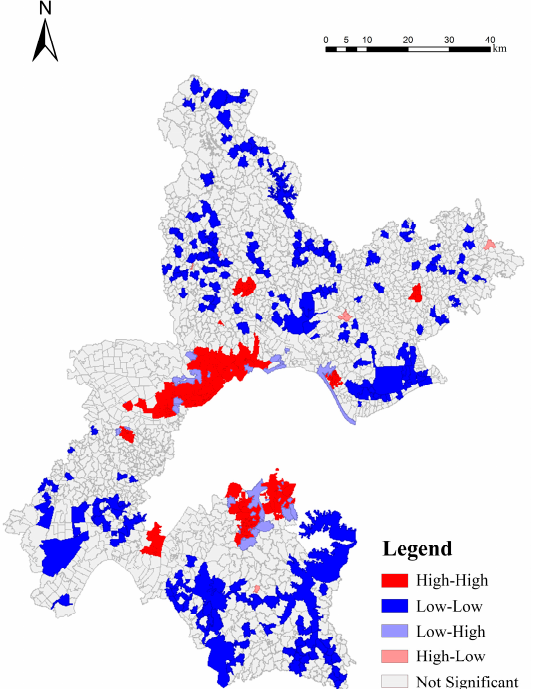
Figure 5. LISA map of market services industries in Wuhan city’s new urban districts.